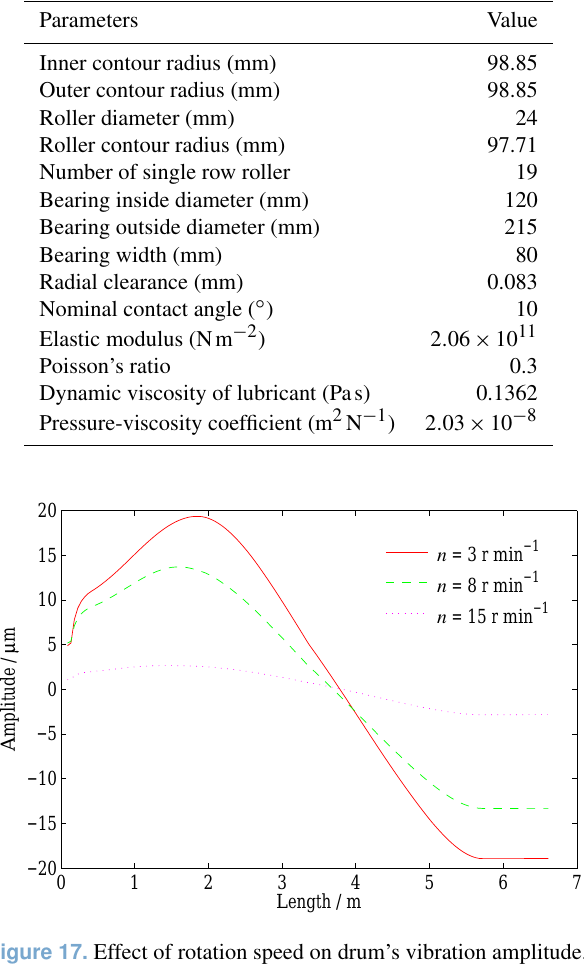
Figure 16a and b show vibration curve of the mixing drum with n = 3 rmin − 1 , β = 16 ◦ , h = 0 m. As shown in Fig. 16b, the response curve distributes asymmetrically. The vibration amplitude first increases to the maximum value and then gradually decrease ( L = 5 . 6 m). The vibration amplitude of the drum is almost not changed at the right side of the roller